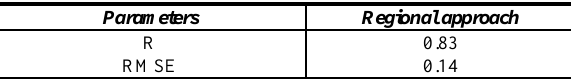
Table 2. Assessment of the relationship between the surface characteristics variations and the LST